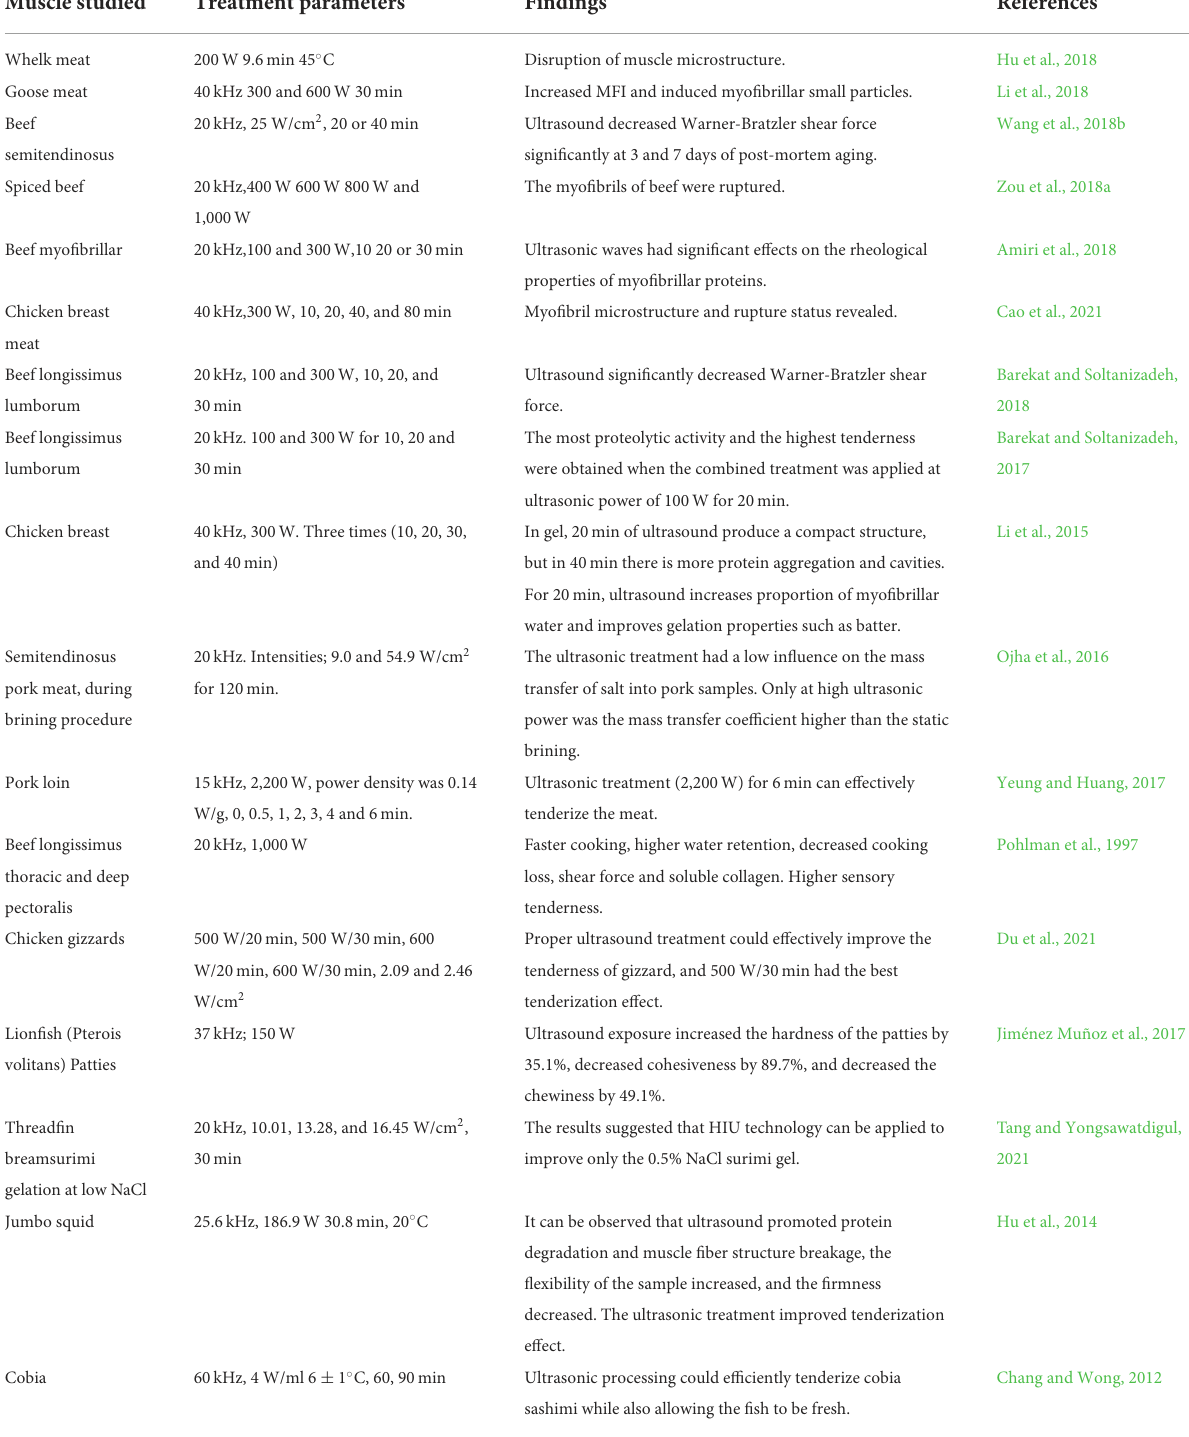
TABLE 1 Findings of various studies elucidating the effect of ultrasound on the tenderness of different